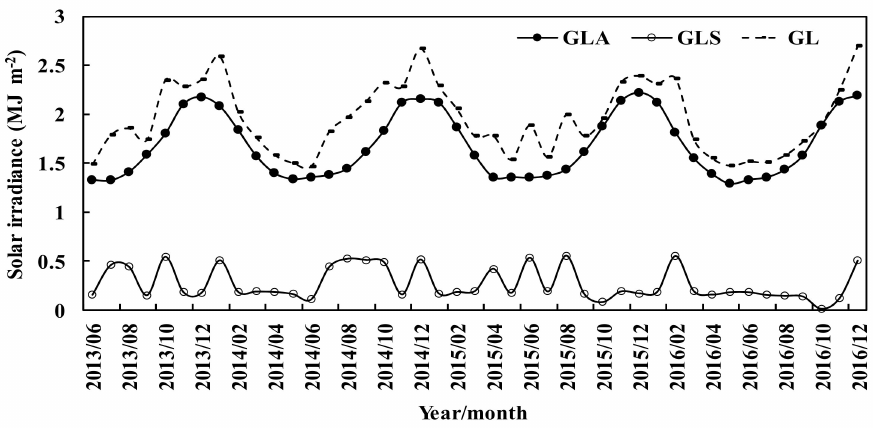
Figure 5. Calculated losses of global solar irradiance during June 2013 to December